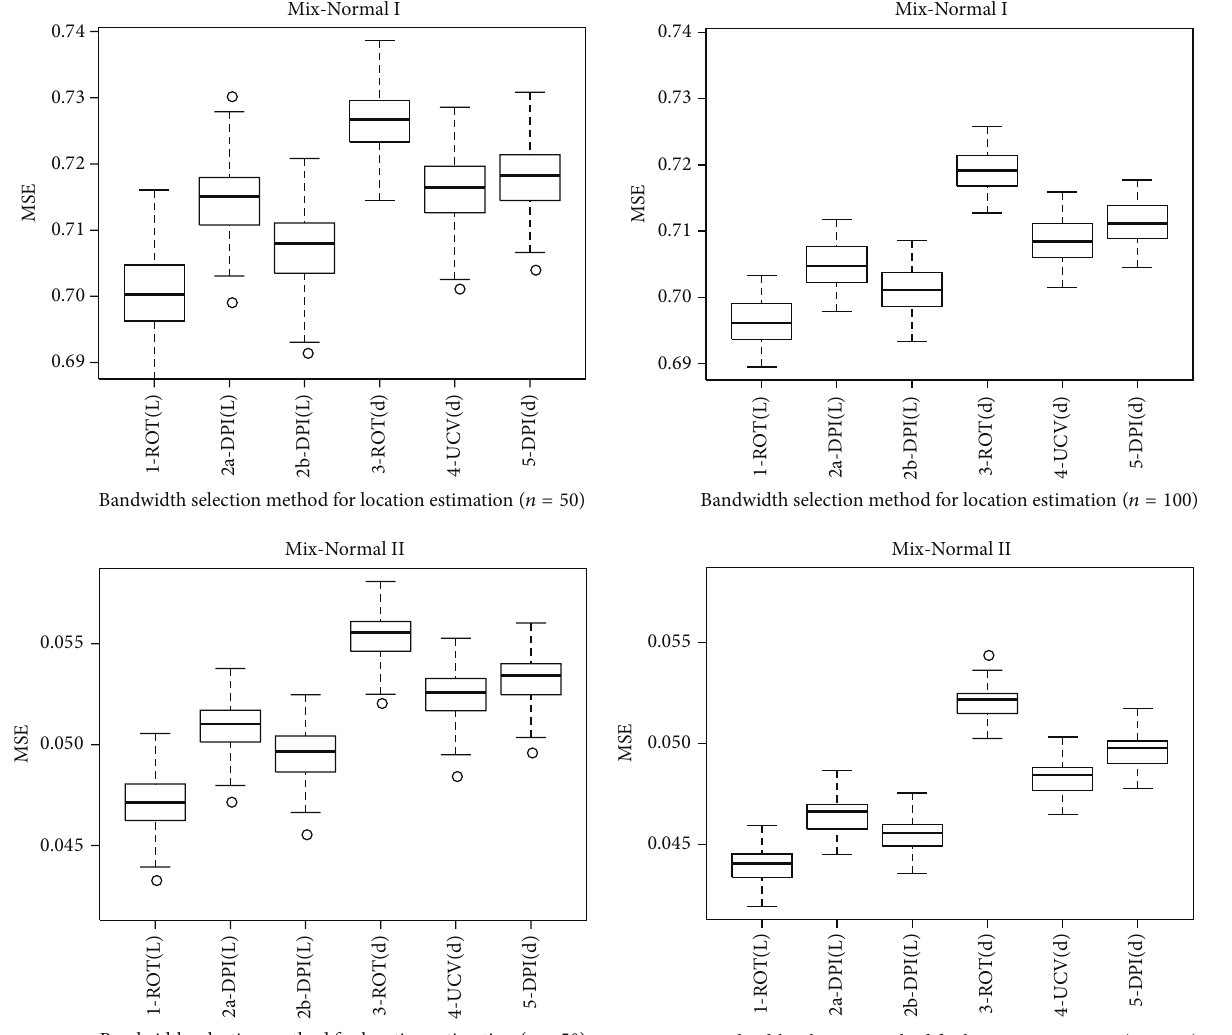
̂ℎ ; “2a-DPI(L)” means with pilot bandwidth ROT ;𝑈 2 DPI ;𝑈 2 ̂ℎ ̂ℎ ; “4-UCV(d)” means ; “5- ROT ; density LSCV ; density